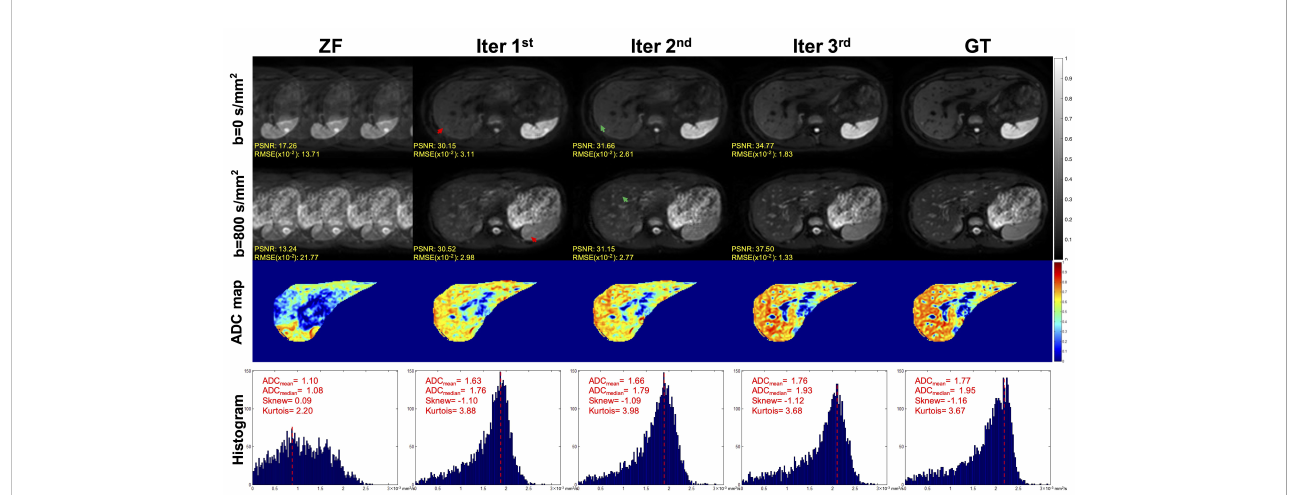
FIGURE 4 Iterative iMCGAN reconstruction at the AF of 4. The PSNR and RMSE values are shown in the corner. For a fair visual comparison, the images were normalized to [0, 1]. The selected whole-liver ADC maps and the corresponding ADC histograms are shown in the third and fourth rows. The histogram parameters are displayed in the upper left corner.